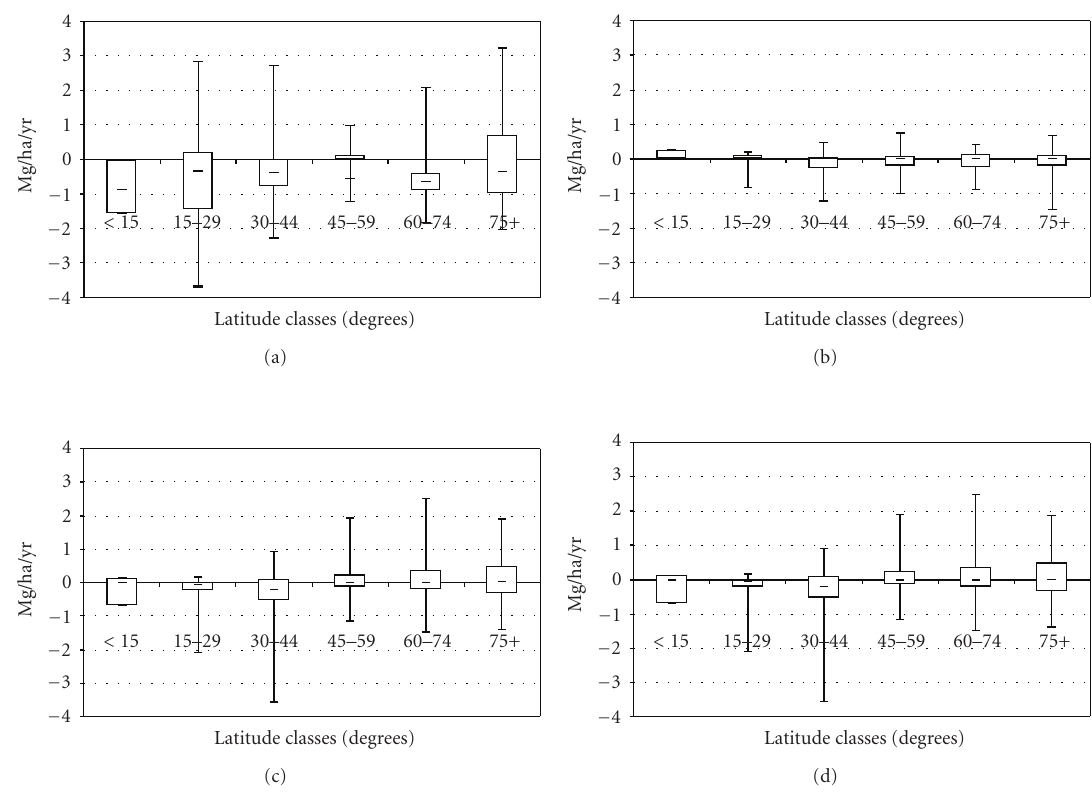
Figure 5: Box plots of carbon flux (Mg/ha/yr) by 15-year stand age classes for (a) standing live trees, (b) standing dead trees, (c) coarse woody debris, and (d) fine woody debris across the north central United States, 2002 to